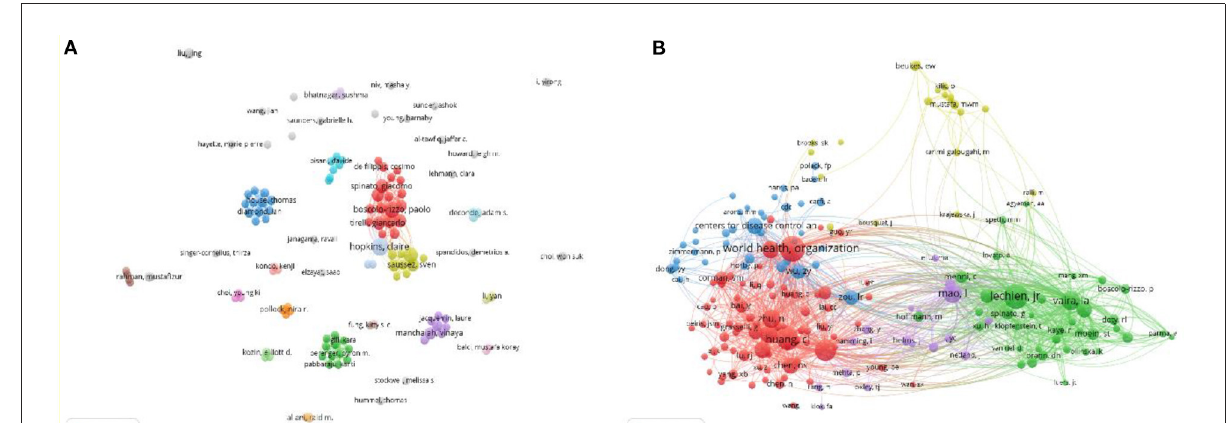
FIGURE4 Visualization map of the scientific collaboration network analysis of COVID-19-related otorhinolaryngology research field. Collaboration among author (A) and co-cited author (B) .